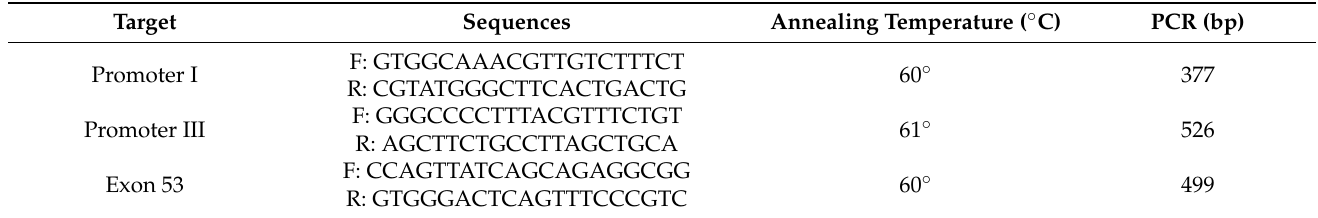
Table 2. PCR primers used to sequence promoter I, promoter III, and Exon 53 in the Najdi sheep ACAC α